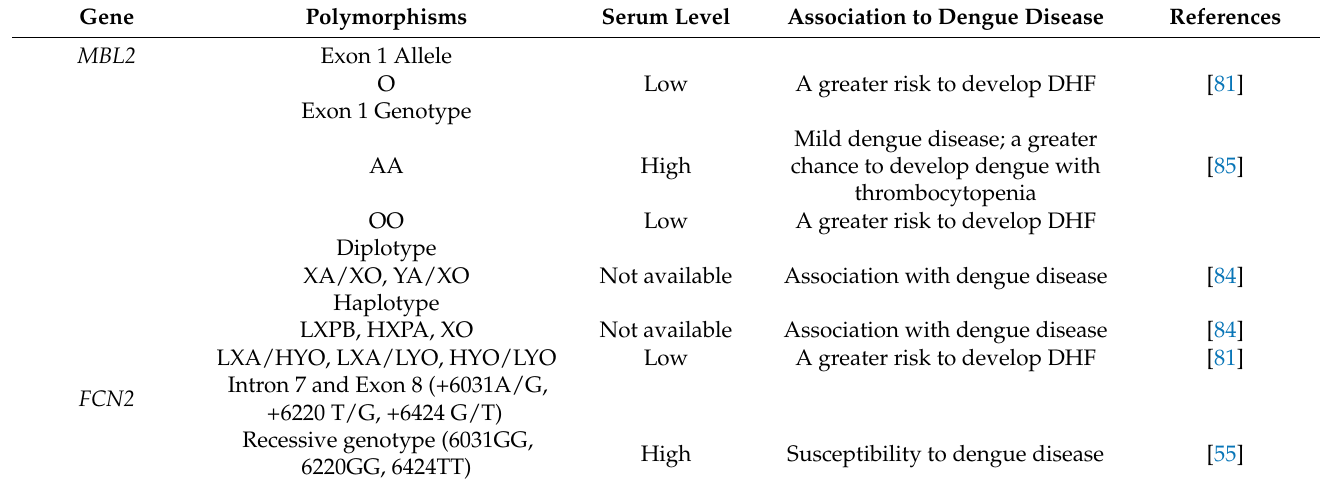
Table 3. Allele, genotype and haplotype of the polymorphisms in MBL2 and FCN2 associated with dengue disease. Gene Polymorphisms Serum Level